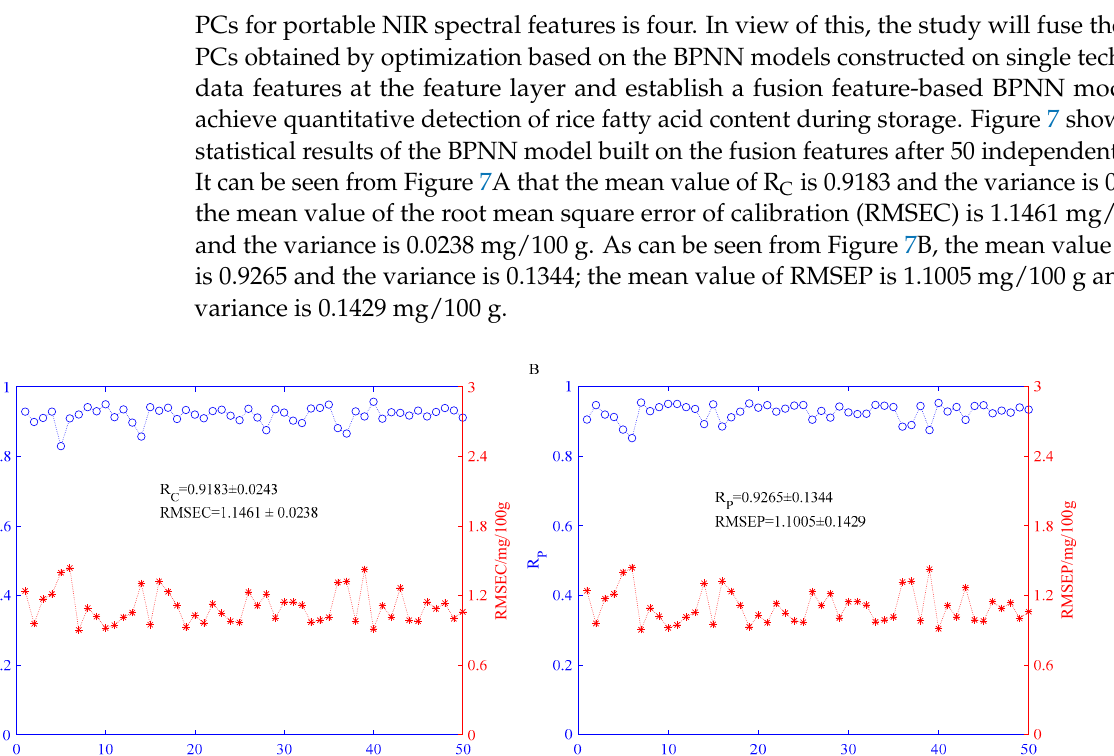
Figure 6. Statistical results of BPNN model based on portable NIR spectroscopy features after 50 independent runs. ( A ) Statistical results of BPNN models established under different PCs in the training set; ( B ) statistical results of the BPNN models established when PCs = 4 in the prediction set.